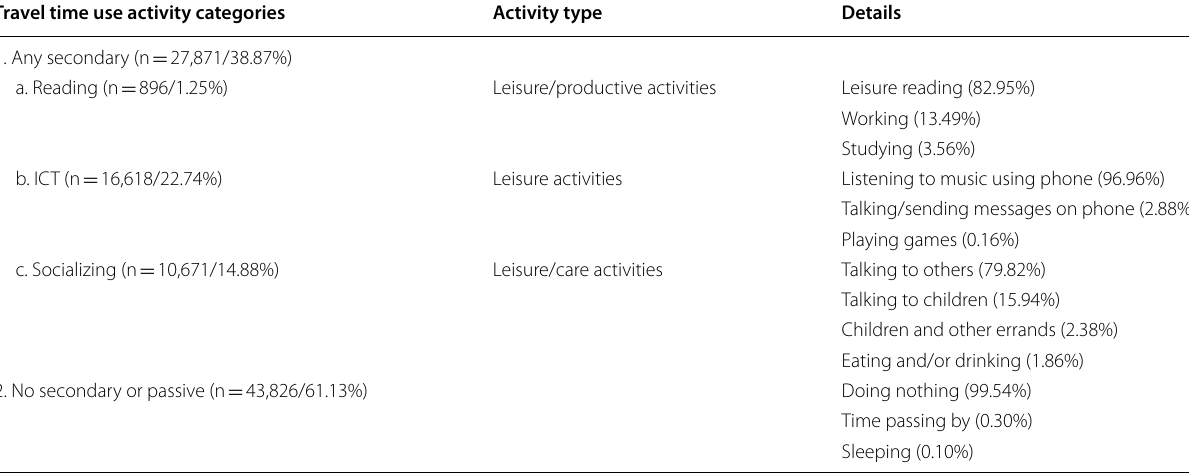
Table 1 Travel time use activities derived from GTUS data Travel time use activity